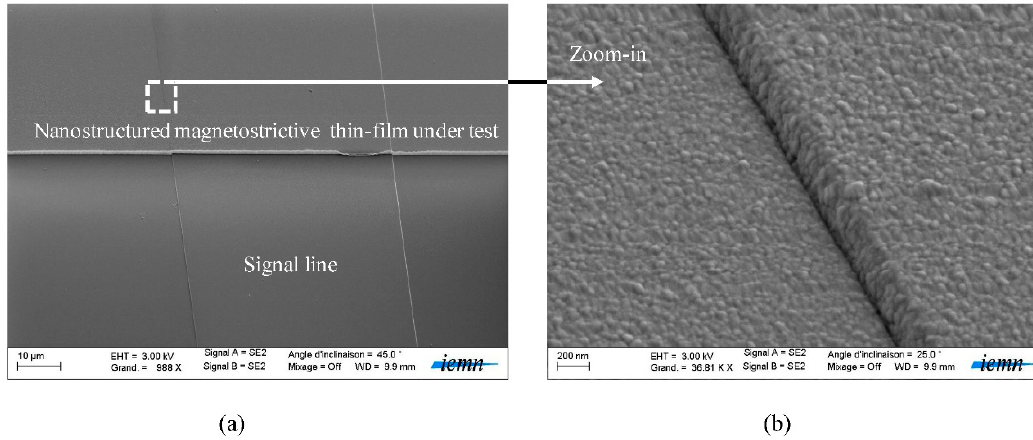
Figure 2. ( a ) SEM,image of the 14×[TbCo 2 (3.7 nm)/FeCo (4 nm)] deposited on a CPW. ( b ) Zoom-in on the nanostructured multi-layer